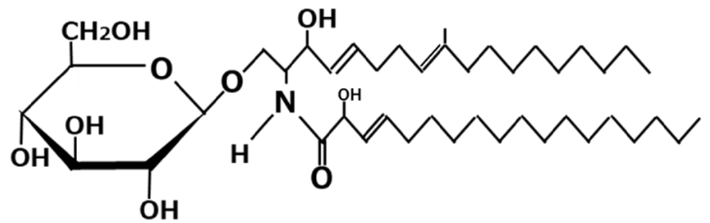
Figure 2. Chemical structure of glycosylceramide.